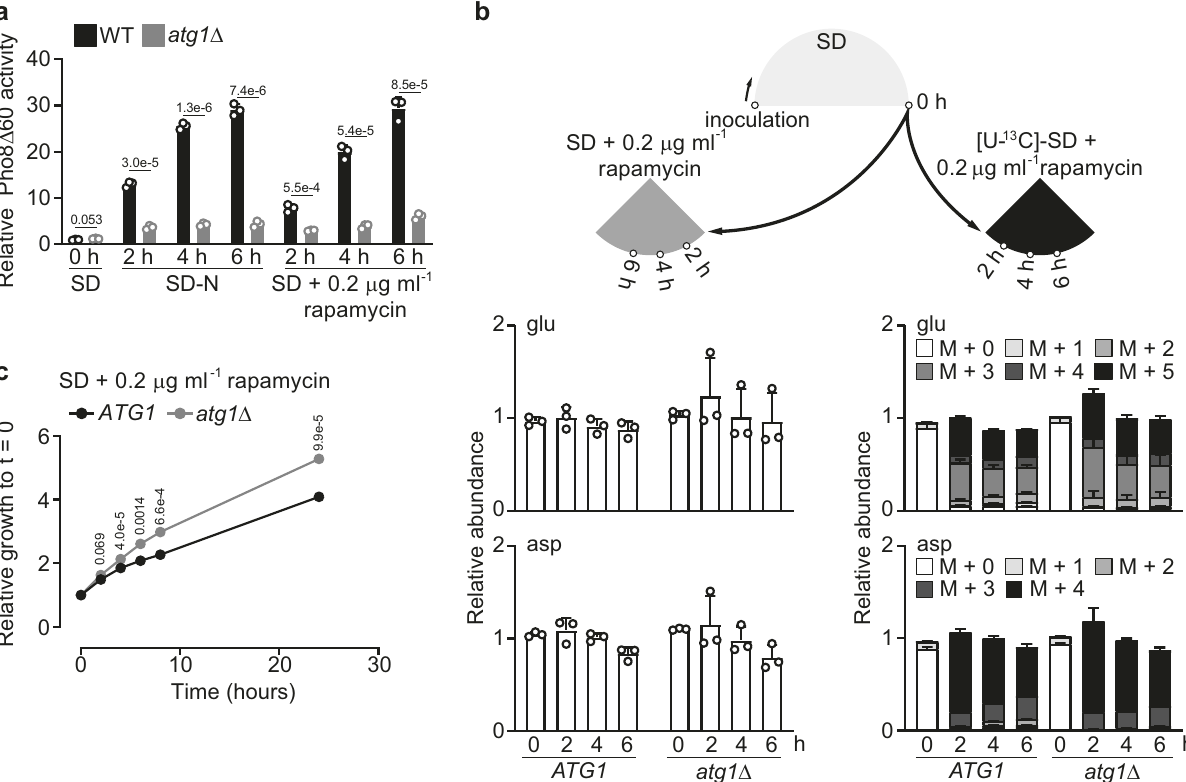
Fig. 4 Characterization of rapamycin-induced autophagy in the presence of nitrogen. a Rapamycin treatment induces autophagy in the presence of nitrogen. Three independent replicates. All samples were normalized to WT cells grown in SD. b Changes of glutamate and aspartate in rapamycin-treated WT ( ATG1 ) and atg1 Δ cells in the presence of nitrogen. Three independent replicates. c Autophagy de fi ciency renders yeast cells more recalcitrant to growth inhibition by rapamycin. Cells were grown in SD to log phase, and washed and resuspended in prewarmed SD + rapamycin with a starting OD 600 ~0.1. Growth was monitored by measuring OD 600 at indicated time intervals. Three independent replicates. P values were calculated using unpaired two- sided Student ’ s t test assuming equal variances. Data are presented as mean ± standard